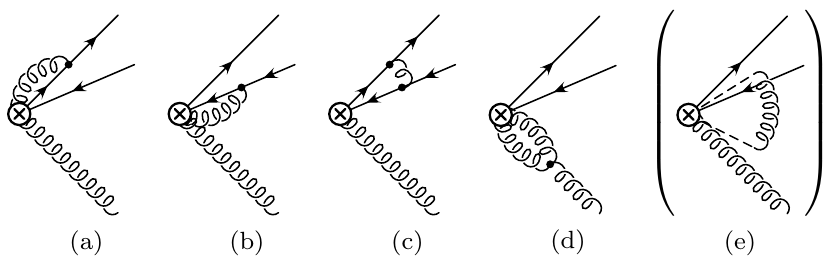
Figure 3 . The Feynman diagrams for any operator with the q n (cid:22) q n g (cid:22) n con(cid:12)guration. The Feynman rules for the e(cid:11)ective vertex are determined by the structure of each operator. Diagram (e) is the overlap amplitude, and must be